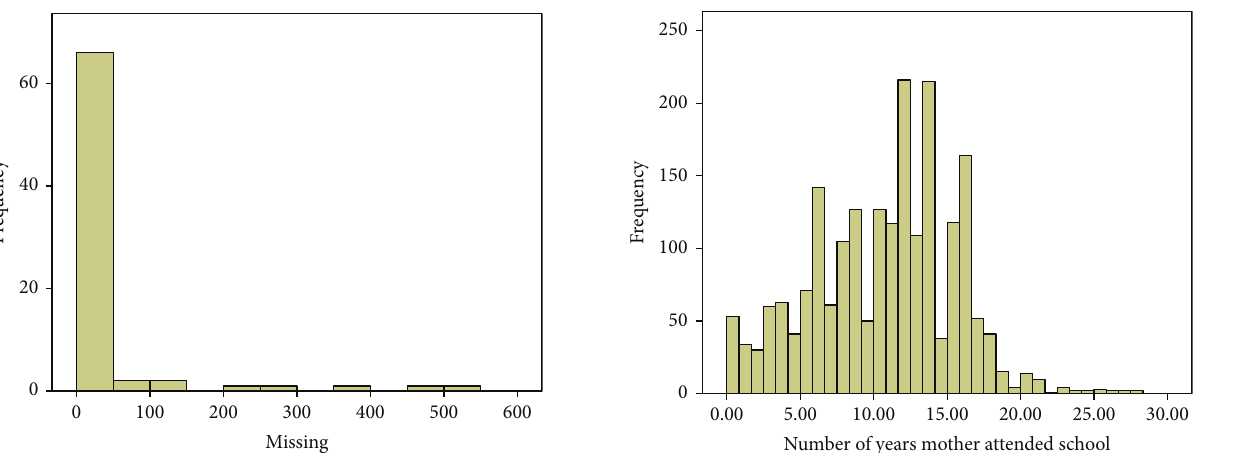
Figure 4: Histogram after imputation of missing values of the number of years the participant’s mother attended school.